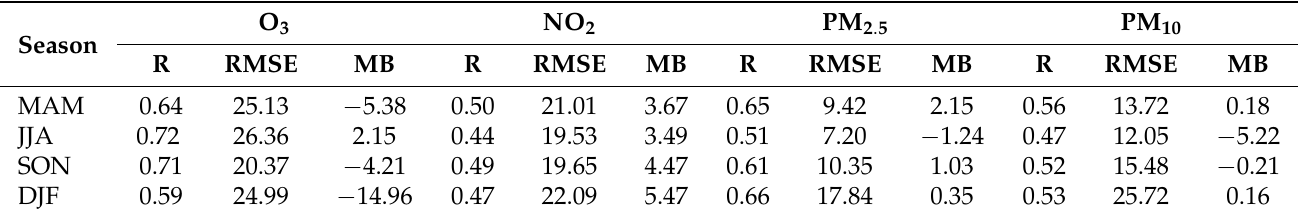
Table 1. Basic statistics over the European domain: correlation coefficient R, root mean square error RMSE ( µ g m − 3 ) and